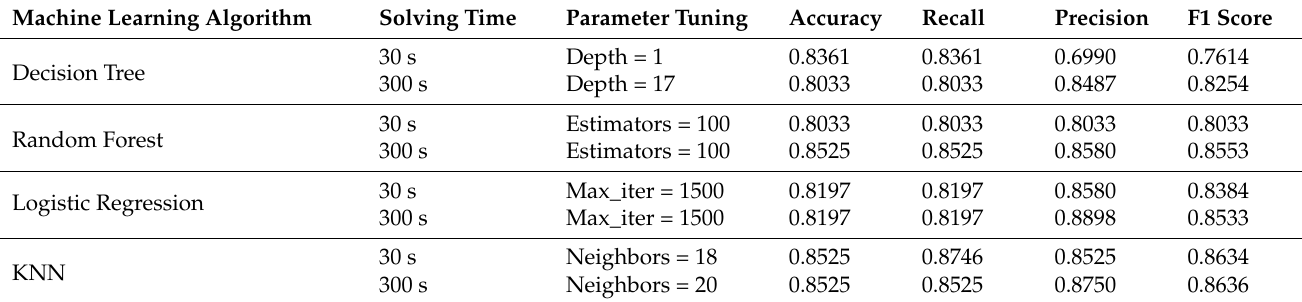
Table 6. Performance metrics of machine learning models on JSSP